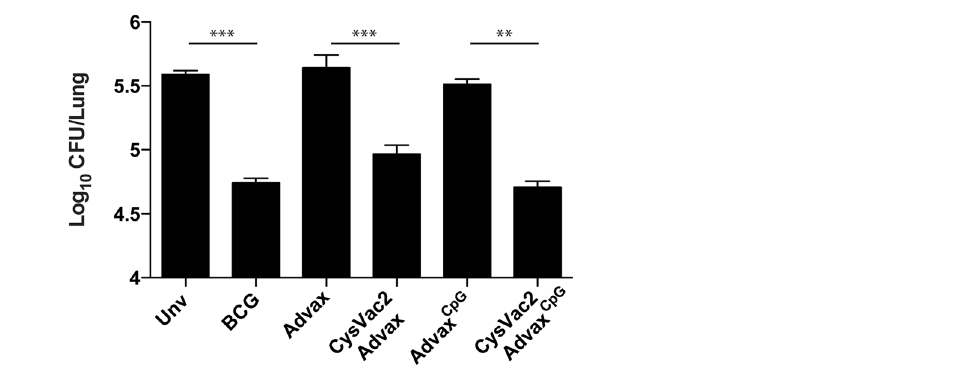
To further characterise immunity post-challenge, the frequencies of antigen-specific, multi-cytokine-secreting CD4 + T cells were compared between groups. CysVac2/Advax CpG -vaccinated mice had the highest frequency of multifunctional IFN- γ + IL-2 + TNF + and IL2 + TNF + CD4 + T cells (Fig. 3D). A similar profile was observed for CysVac2/Advax-vaccinated mice, albeit at a lower frequency. This expansion of multi-functional cells was